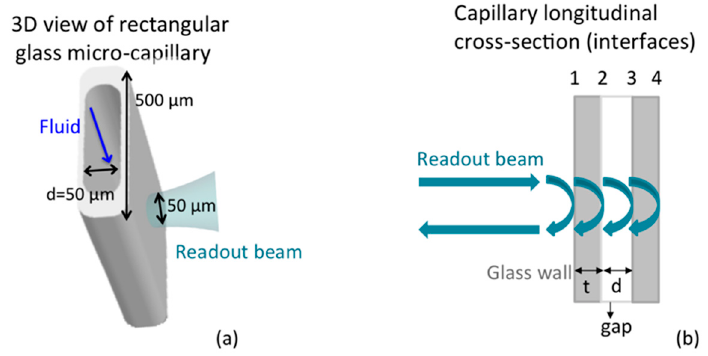
Figure 1. ( a ) 3D sketch of the glass rectangular micro-capillary; ( b ) Schema of a capillary longitudinal cross-section. The four interfaces of the capillary are